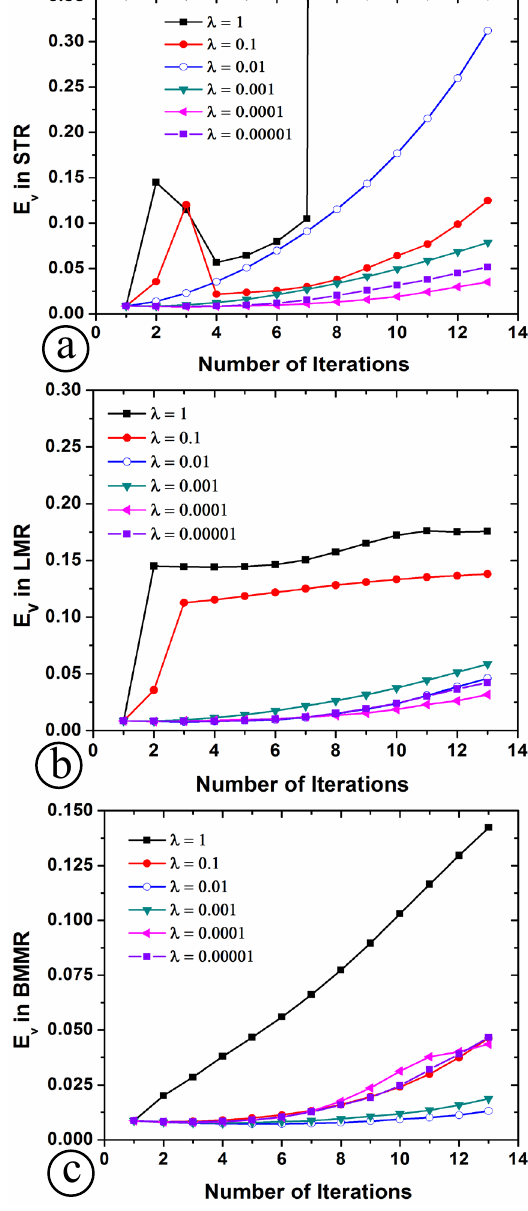
Fig.3: Projection errors (E V ) calculated in the conductivity reconstruction at different iterations with different values of λ: (a) with STR, (b) with LMR, (c) with